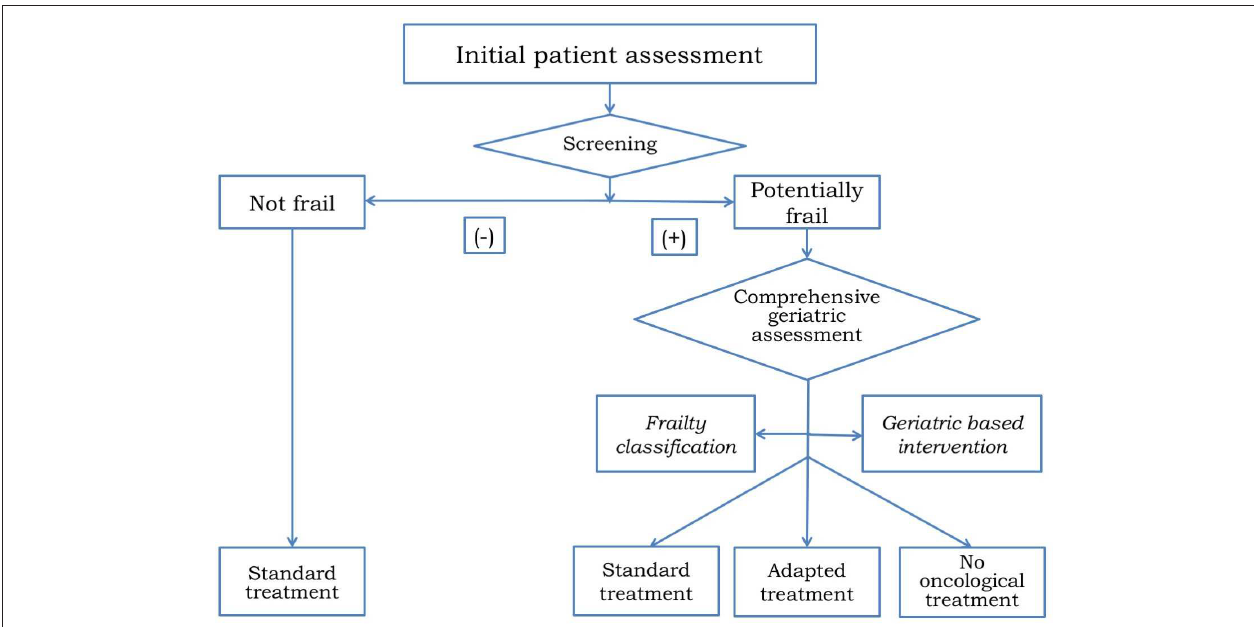
FIGURE 4 | Algorithm for treatment decision making in older patients with